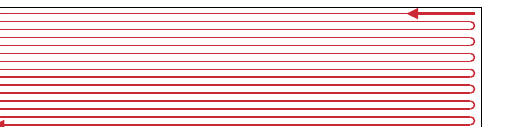
Figure 2. Printing path for one layer of CF/PA6 bending test specimens with 0° fiber direction.